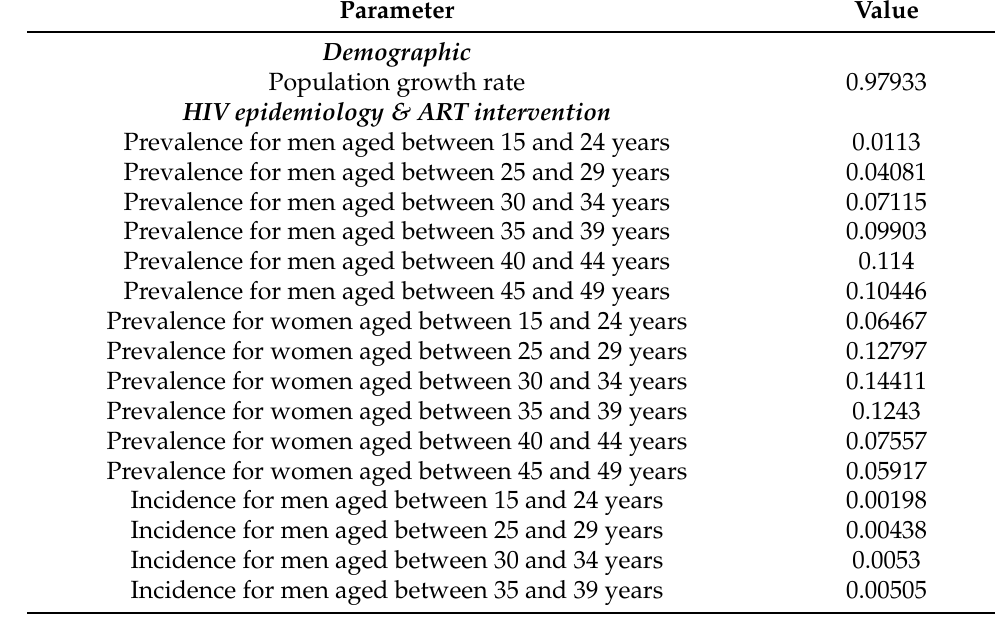
Figure A1. Relative error between input parameter values which generated the benchmark data and best fit parameters’ from calibration.